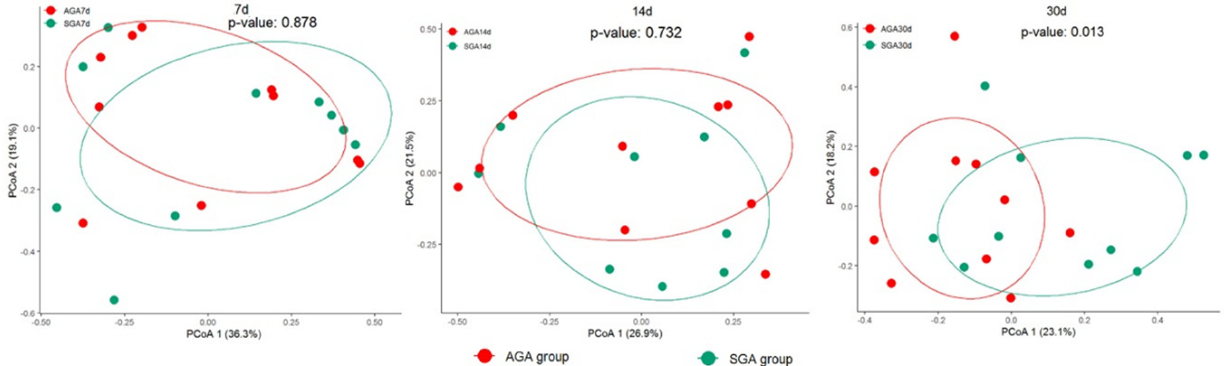
( p = 0.878) and 14 ( p = 0.732).